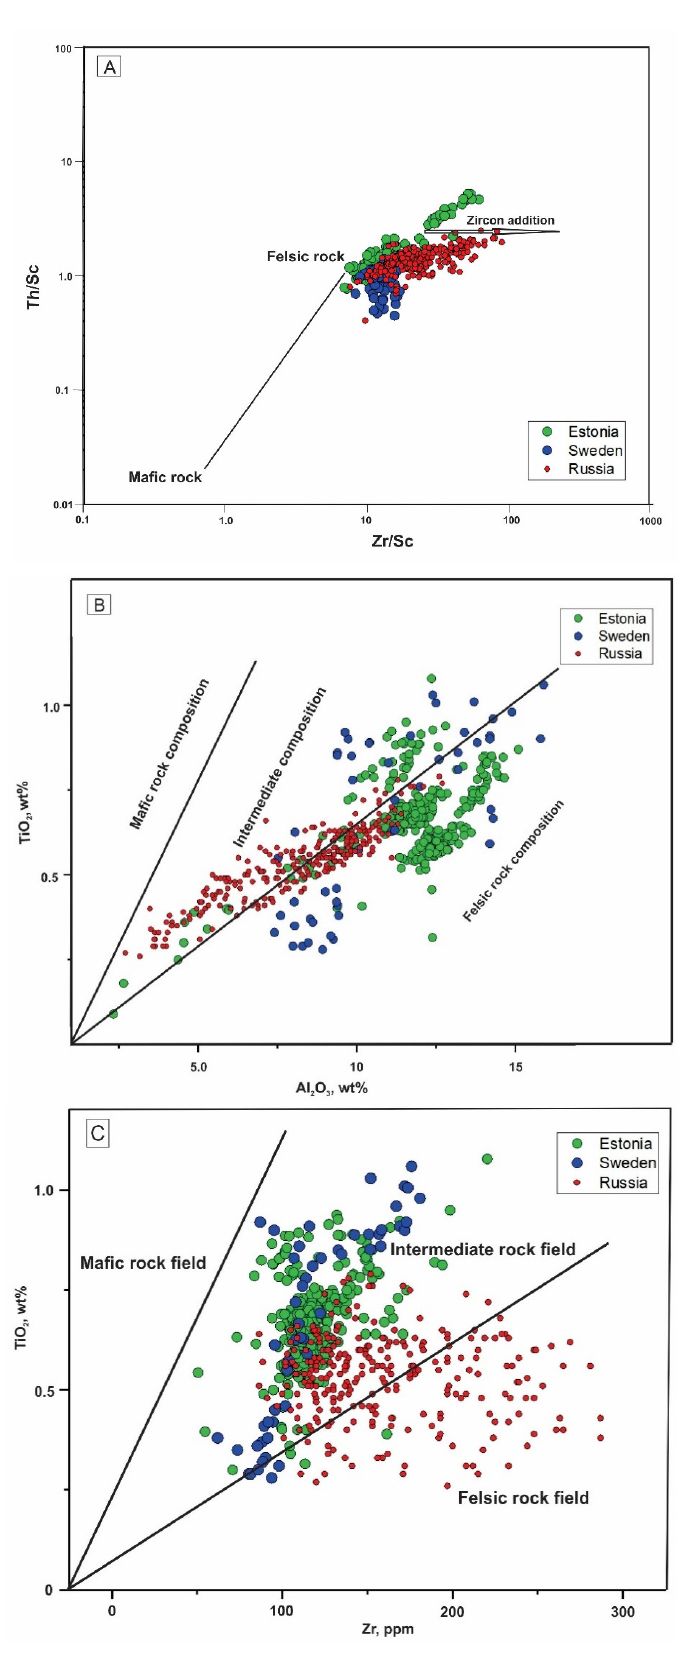
Figure 4. Provenance discrimination diagrams: ( A ) Th/Sc versus Zr/Sc [46]; ( B ) TiO 2 versus Al 2 O 3 ; ( C ) TiO 2 versus Zr [2].